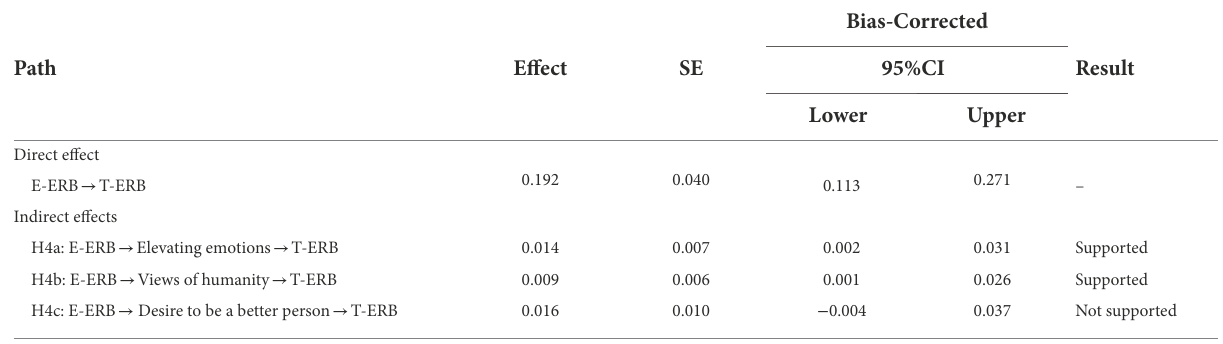
TABLE 4 Results of mediating